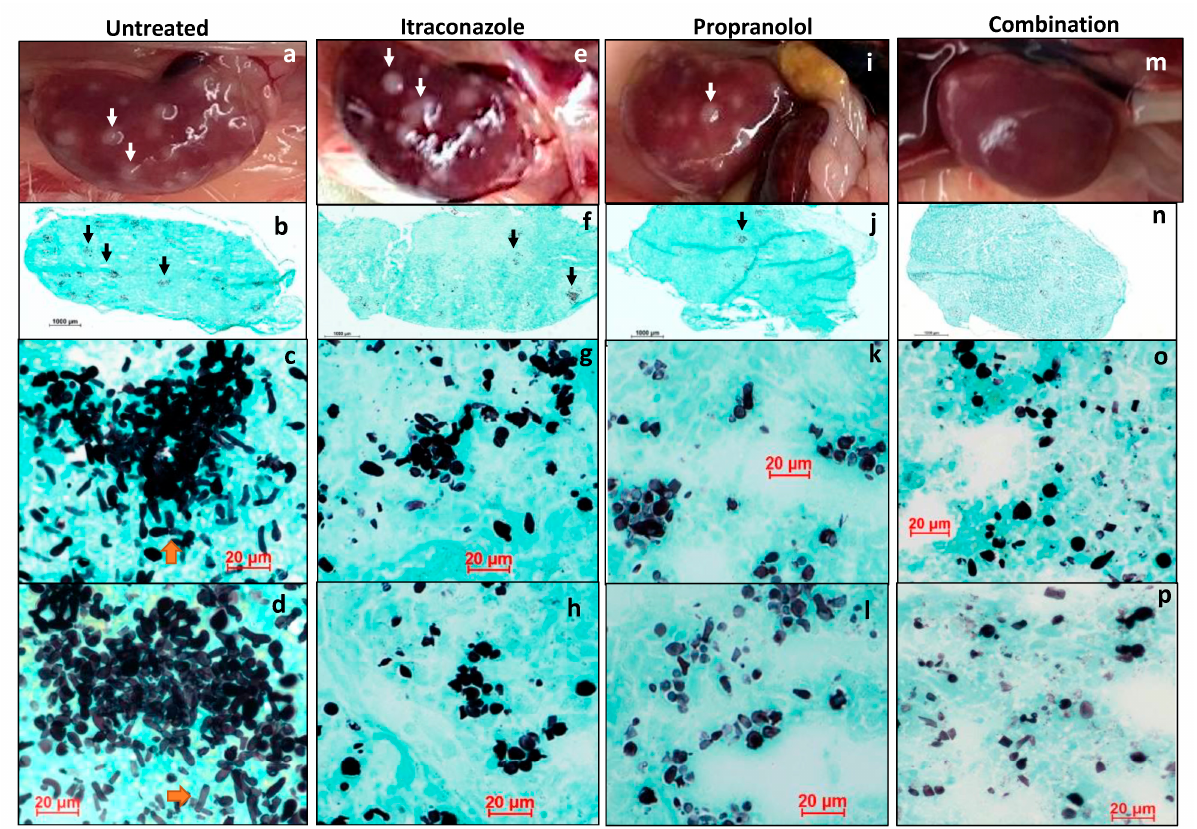
Figure 6. Grocott-Gomori’s methenamine silver (GMS) stain for fungi load. Untreated kidney ( a – d ): ( a ) gross image of the kidney with white infective foci (white arrow); ( b ) whole mount of kidney, Grocott-Gomori’s methenamine silver (GMS) stain for fungi shows small colonies of fungi (black arrows); ( c , d ) representative images, GMS stain, 40 × magnification, high power view of the large collections of fungal elements composed of numerous pseudo-hyphae and elongated yeast cells. Itraconazole treated kidney ( e – h ): ( e ) gross image of the kidney with white infective foci (white arrow); ( f ) whole mount of kidney, GMS stain for fungi shows fewer colonies of fungi (black arrows); ( g , h ) representative images, GMS stain, 40 × magnification, high power view of the smaller fungal clusters that show fewer pseudo-hyphae and a larger proportion of elongated yeast cells. Propranolol treated kidney ( i – l ): ( i ) gross image of the kidney with white infective foci (white arrow); ( j ) whole mount of kidney, GMS stain for fungi shows fewer colonies of fungi (black arrows); ( k , l ) representative images, GMS stain, 40 × magnification, high power view of the smaller fungal clusters show occasional pseudo-hyphae and a predominance of elongated yeast cells. Combination treated kidney ( m – p ): ( m ) gross image of the kidney with white infective foci (white arrow); ( n ) whole mount of kidney, GMS stain for fungi shows fewer colonies of fungi (black arrows); ( n – p ) representative images, GMS stain, 40 × magnification, high power view of the fungal elements show occasional clusters of fungal elements composed mainly of elongated yeast cells. In